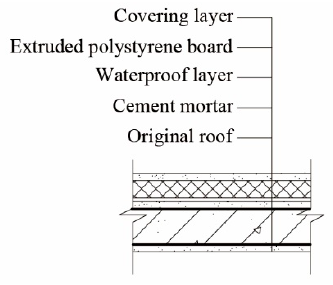
Figure 28. Outdoor roof insulation.